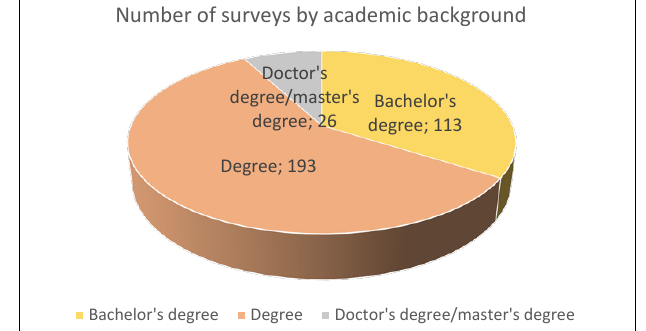
FIGURE 1 | Distribution of participants according to academic